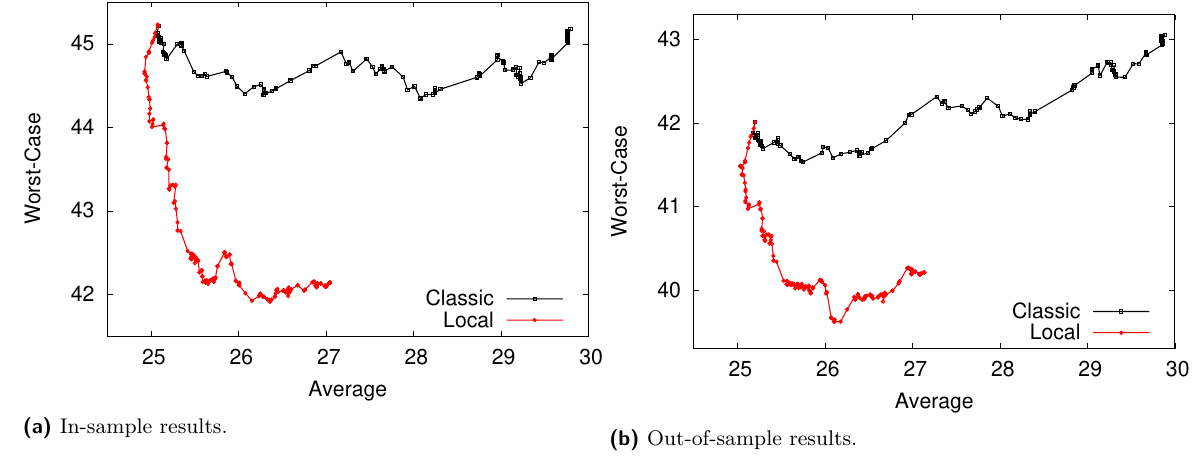
Figure 6 Experiment 4: Average versus average worst-case objective value for different budget